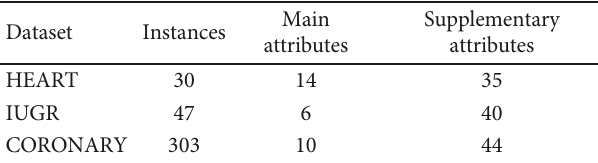
Table 1: The characteristics of